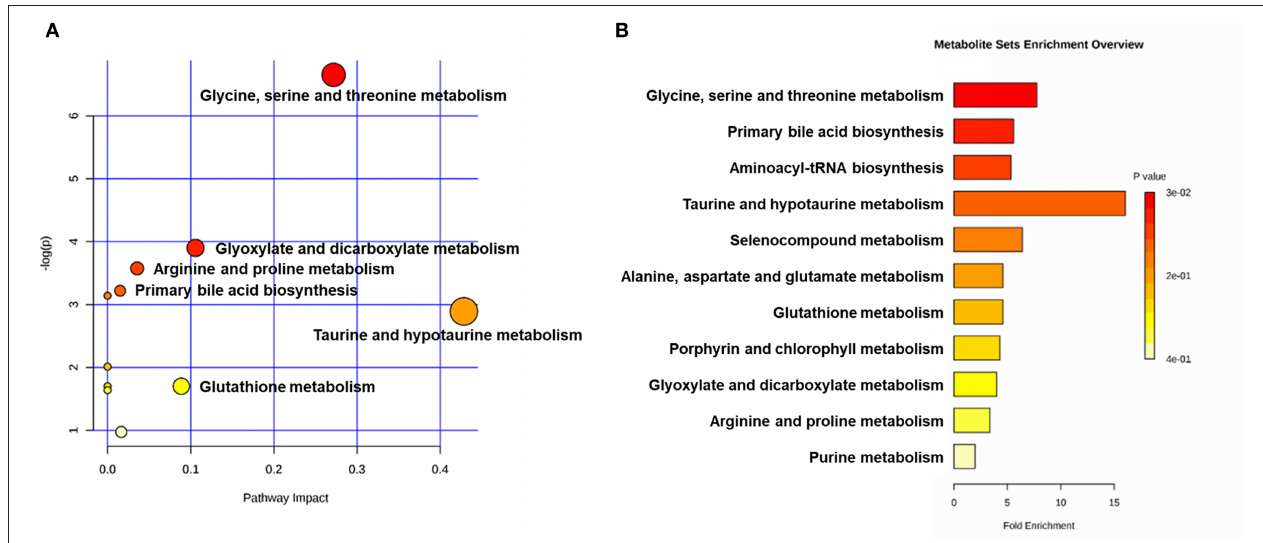
FIGURE 6 | Metabolic pathway analyses utilizing the MetaboAnalyst functional interpretation tools. (A) Bubble plot of metabolic pathway impact. The metabolic pathways are shown as bubbles. The X coordinate and size of the bubble represent the value of pathway impact in the topology analysis. The Y coordinate and color of the bubble represent the P- value of the enrichment analysis. The darker red color and larger size indicate a more significant metabolite change in the corresponding pathway. (B) Metabolite set enrichment analysis (MSEA) plot. Significantly enriched pathways are represented by bars. The color and length of the bar are based on the P- value and fold enrichment,